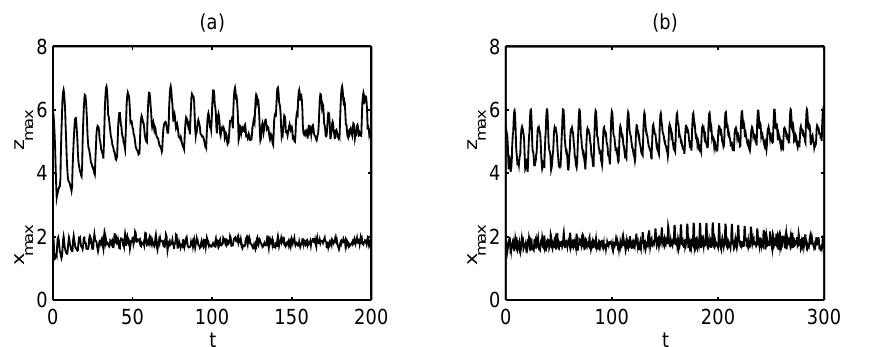
FIG. 3. Maximum (cid:120) and (cid:122) as a function of time for initially matched beam m (cid:120) (cid:173) m (cid:121) (cid:173) m (cid:122) (cid:173) (cid:49)(cid:46)(cid:48) with 6D Gaussian distribution ( (cid:99) (cid:121) (cid:97) (cid:173) (cid:51) ): (a) h (cid:120) (cid:173) (cid:48)(cid:46)(cid:51)(cid:56)(cid:44) h (cid:122) (cid:173) (cid:48)(cid:46)(cid:50)(cid:55) , (b) h (cid:120) (cid:173) (cid:48)(cid:46)(cid:55)(cid:53)(cid:44) h (cid:122) (cid:173) (cid:48)(cid:46)(cid:54)(cid:53) .